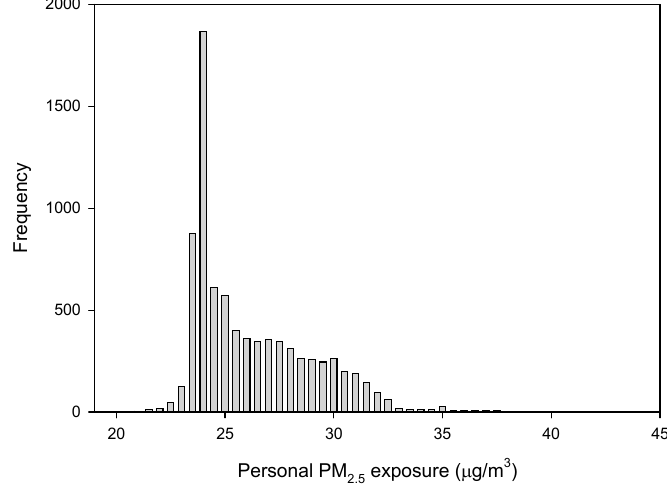
3 ) of 8072 residents of